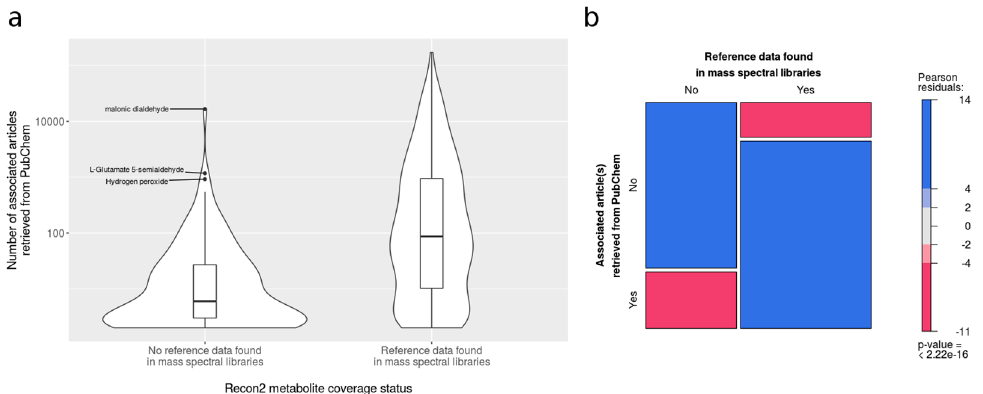
Figure 8. Relationship between the coverage status of Recon2 metabolites and the scientific literature. ( a ) Violin plots showing the distribution of the number of articles associated with mapped and non-mapped metabolites in Recon2. Y axis shows the number of articles (logarithmic scale) obtained from PubMed references in PubChem entries. Only metabolites with at least one associated article are considered. ( b ) Mosaic plot showing the proportion of Recon2 metabolites with PubMed references. Only metabolites with PubChem CID annotation were considered. The area of the tiles is proportional to the number of metabolites within each category. The color and shade of the tiles correspond to the sign and magnitude of the Pearson residuals. The Pearson residuals represent the contribution of the tile to the chi-squared statistics, assessing whether the two variables are independent or not. Red tiles indicate the proportion of under-represented metabolites, namely, metabolites with a smaller number of PubMed references than expected if the two variables (i.e., an entry in spectral libraries and a PubMed article in PubChem) were independent, while blue tiles indicate over-represented metabolites, namely, metabolites with a greater number of PubMed references than expected.